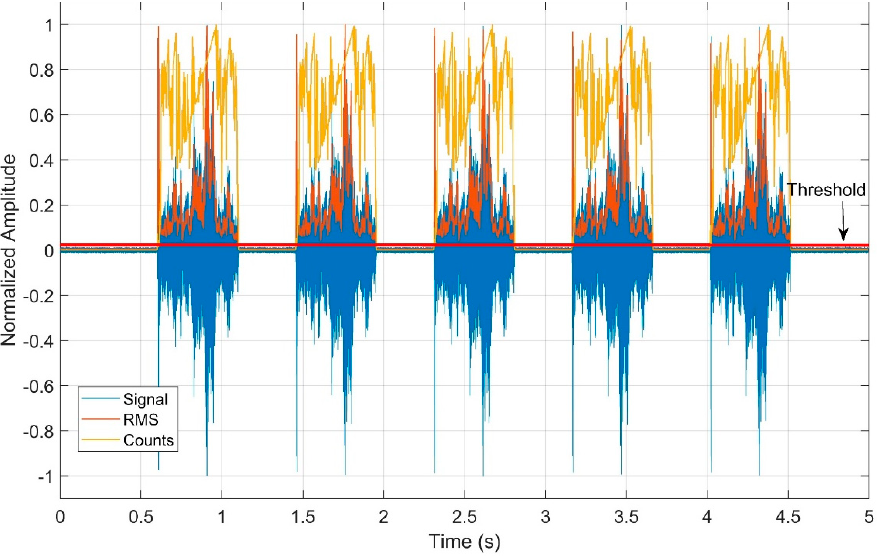
Figure 7. Statistics used to analyze the received packages—root mean square (RMS) and Counts.